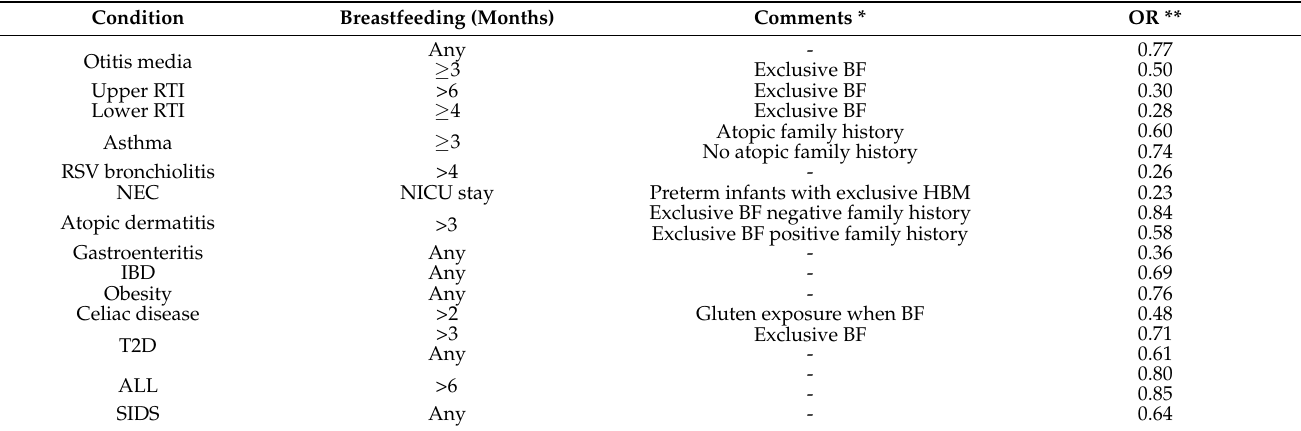
Table 2. The odds ratio of different diseases among breastfed people compared with commercial infant formula-fed or referent group